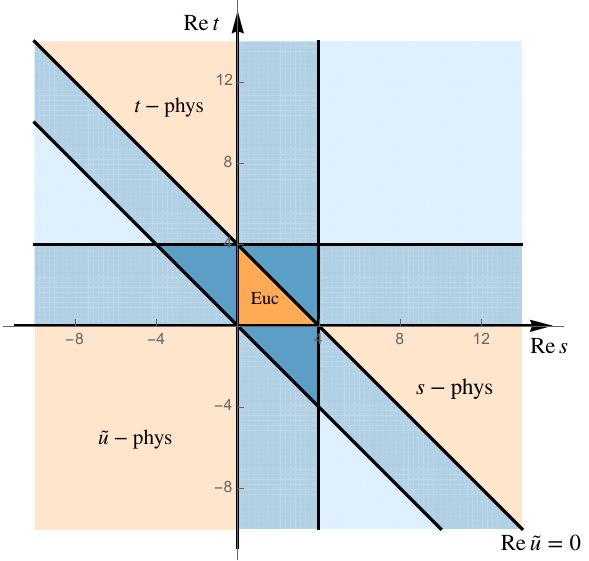
Figure 6. The Mandelstam ( s, t ) plane, colored according to the analytic continuation necessary to reach each region. The main distinction is orange versus blue: in the former one should take ρ and ¯ ρ to be complex conjugates and in the latter they are real and independent. A refinement is the dark versus light shading. In the darkest central triangles ρ and ¯ ρ should be taken to live on the first sheet, and passing to lighter shades corresponds to one or two analytic continuations of either ρ or ¯ ρ around either 0 or 1 . Exactly which sheet corresponds to which region is detailed